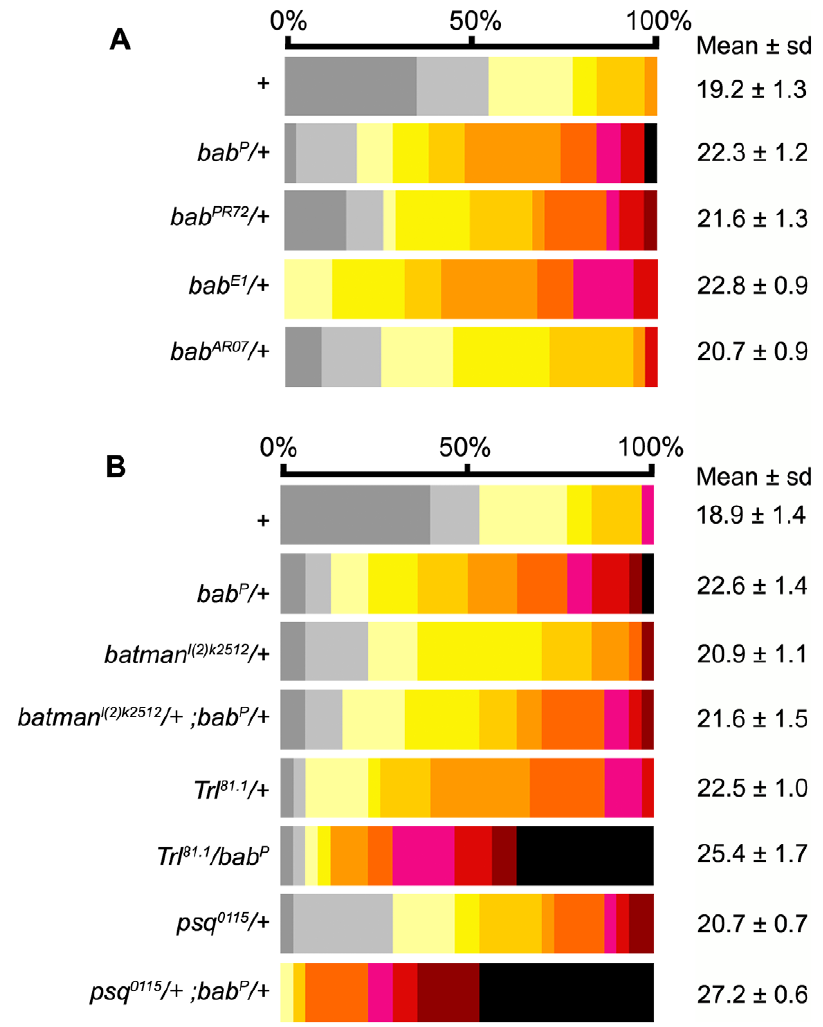
Figure 3. Ovariole number in bab mutant heterozygous combinations. (A) Distribution of the number of ovarioles per ovary in different bab heterozygotes. For statistics (comparison between bab heterozygotes and Canton-S ( + )) see Table S3A. (B) Distribution of the number of ovarioles per ovary in genetic interaction assays between the bab locus and psq , Trl and batman . For statistics (comparison between different allelic combinations) see Table S3B. The mean number of ovarioles per ovary is given on the right. All values are expressed as the mean + / 2 sample standard deviation. Color table as in Figure 1.